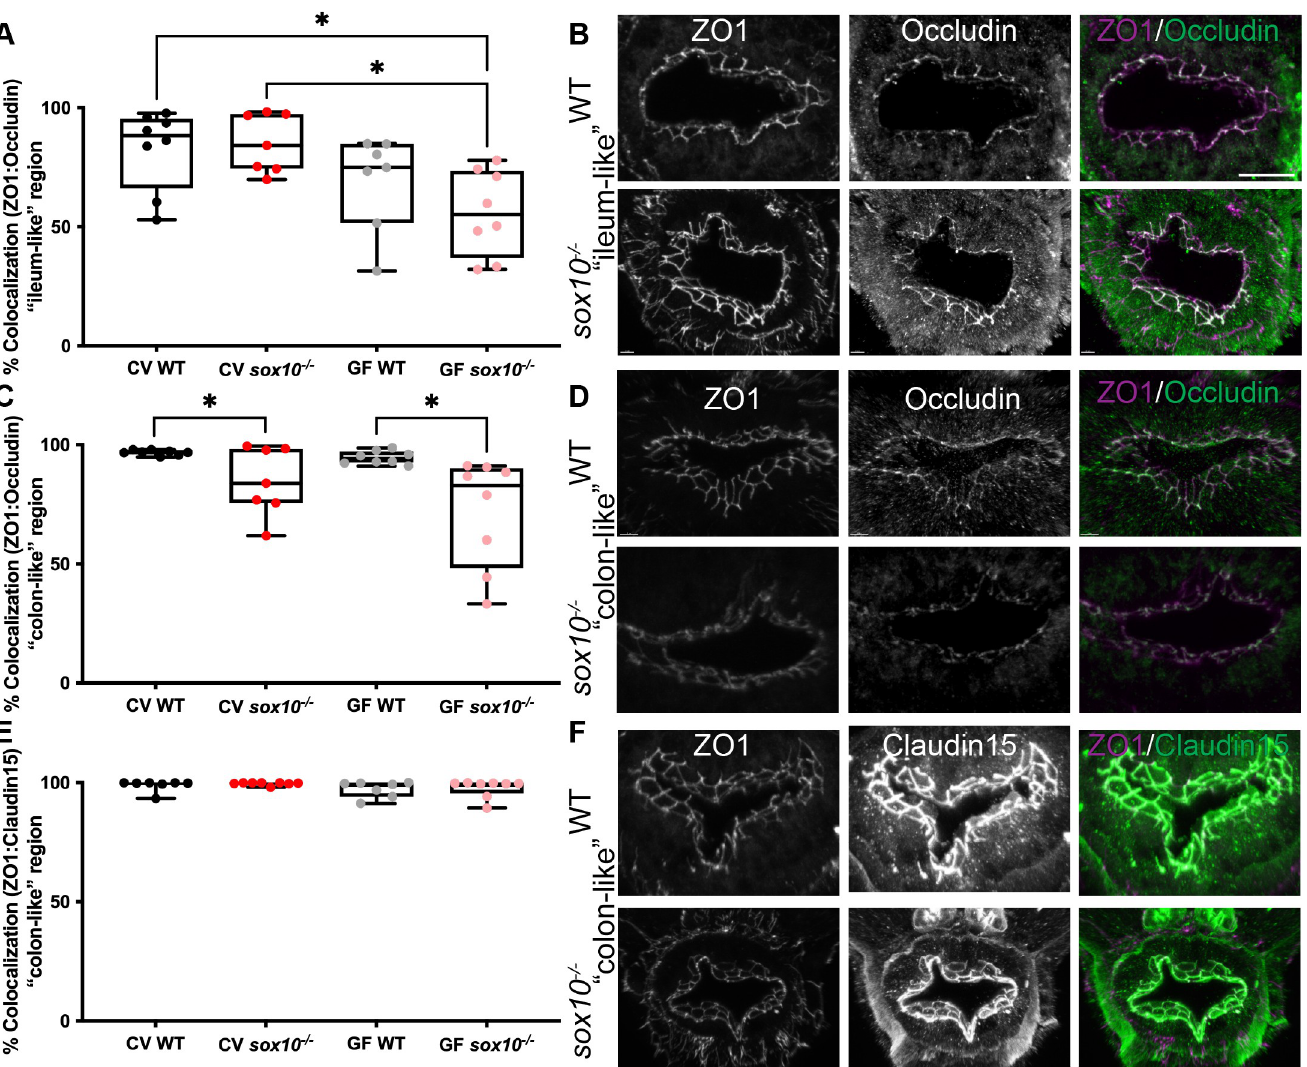
Fig 3. sox10 mutants have altered intestinal tight junctions. (A) Quantification of percent ZO1 colocalized with Occludin in the “ileum-like” region of CV and GF larvae. (B) Representative immunohistochemistry of CV WT and sox10 mutant ZO1, Occludin and colocalization in “ileum-like” region. (C) Quantification of percent ZO1 colocalized with Occludin in the “colon-like” region of CV and GF larvae. (D) Representative immunohistochemistry of ZO1, Occludin and colocalization in “colon-like” region. (E) Quantification of percent ZO1 colocalized with Claudin-15 in the ‘colon-like” region of CV and GF larvae. (F) Representative immunohistochemistry of ZO1, Claudin-15 and colocalization in “colon-like” region. Scale bar = 20 μ m. Each point in A, C and E is the average value of 2–3 sections per fish. Staining was performed on larvae from two independent GF derivations (n > 7). Boxes represent the first to third quartiles, center bar denotes the median, and whiskers the maximum and minimum of each dataset. � p < 0.05. ANOVA followed by Tukey’s post hoc